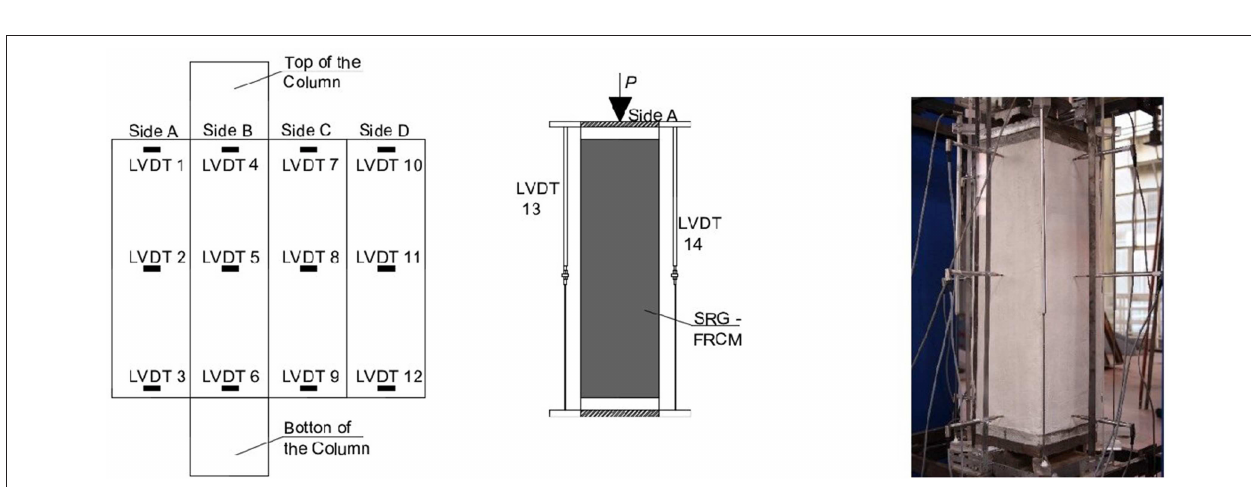
FIGURE 8 | Test set